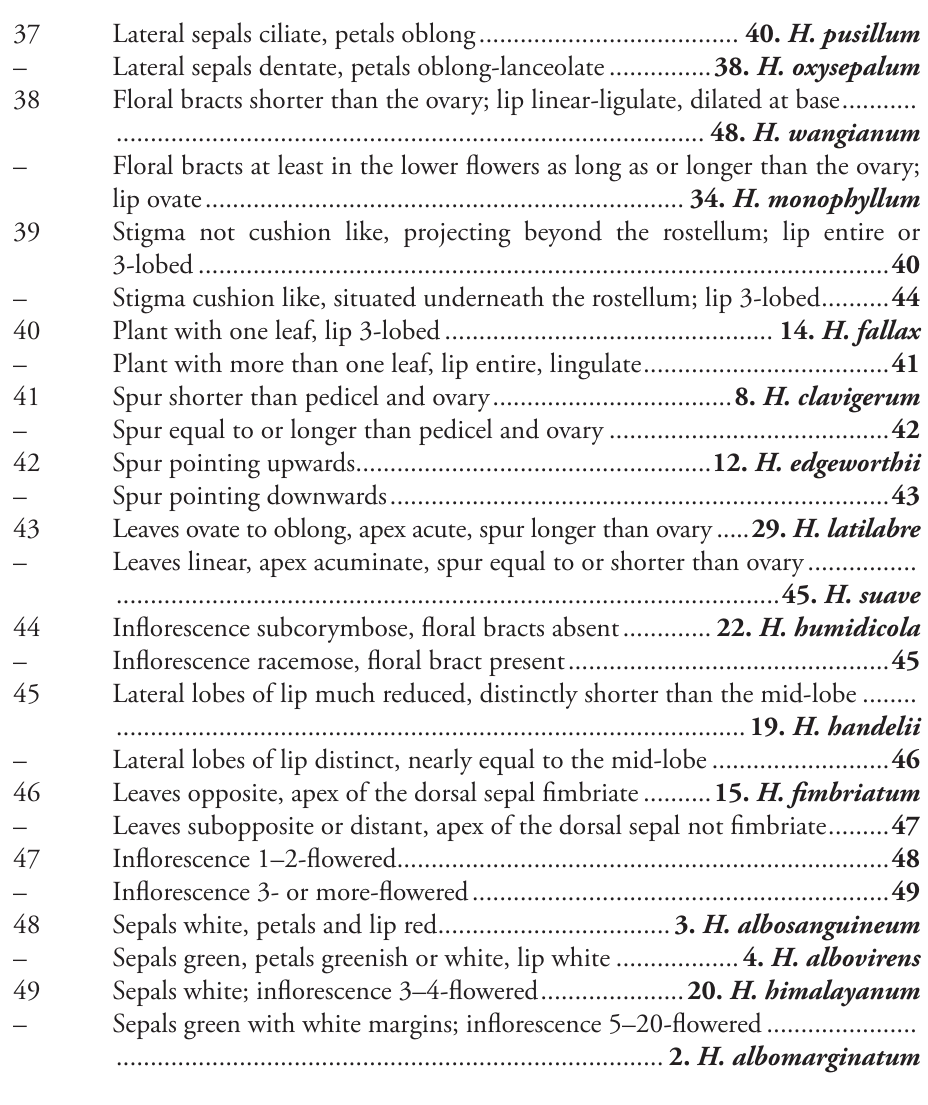
Figs 8M, 9M Monorchis alaschanica (Maxim.) O. Schwarz, Mitt. Thüring. Bot. Ges. 1: 95. 1949. Peristylus alaschanicus (Maxim.) N. Pearce & P.J. Cribb, Edinburgh J. Bot. 58: 117. 2001. Type. MONGOLIA. Mont. Alaschan, 1873, Przewalski N.M., 163 (Holotype: